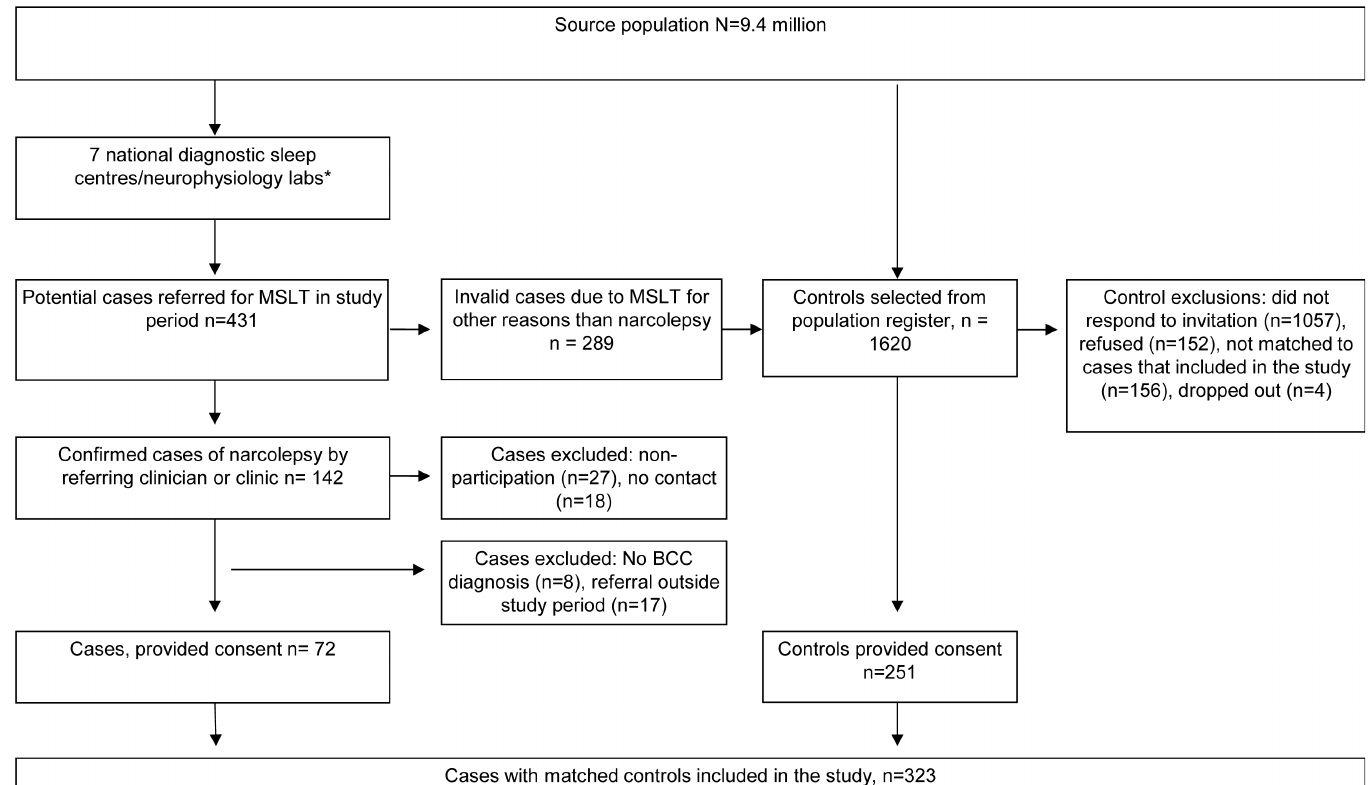
Fig 1. Flowchart to show case and control